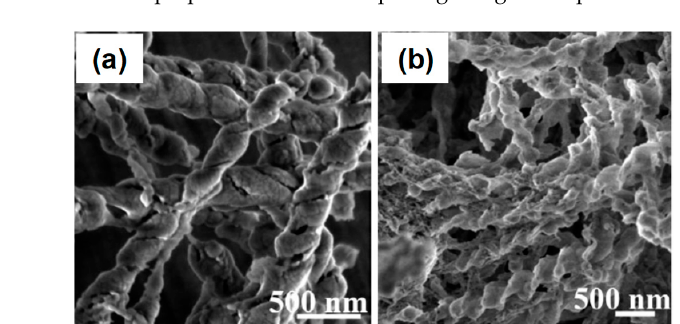
Chart 5. Amphiphiles used for templating inorganic superstructures.